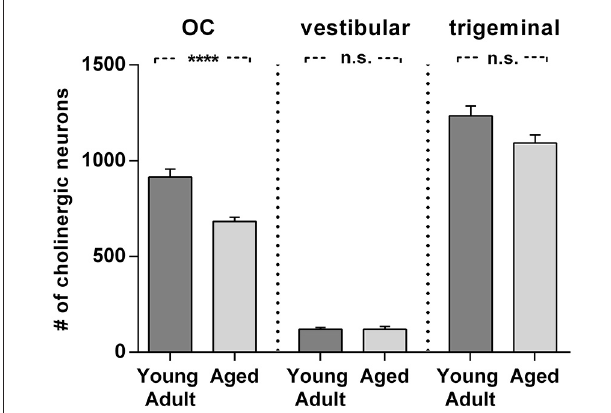
FIGURE 8 | Comparison of age related neuron loss in three cholinergic efferent systems . There is considerable loss in the olivocochlear efferent system (left) of 26% ( t = 4,984; df = 18; p < 0.0001), whereas the vestibular efferent system (middle) is not affected by age and the trigeminal motor system (right) shows only a moderate neuronal loss of 12% ( t = 2.155; df = 18; n.s.). Neuron numbers are given as mean ± SEM. Dark gray columns: young adult animals, light gray columns: aged animals. ∗∗∗∗ p <